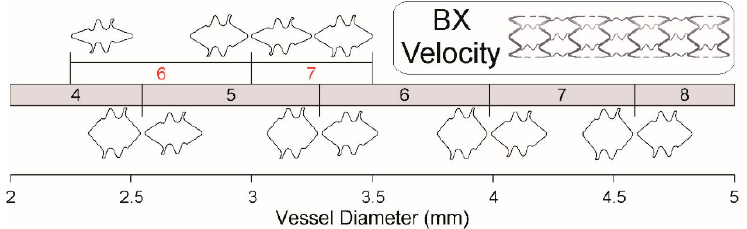
Figure 3. Comparing diameter ranges of a commercial stent vs. its diameter ranges for optimal WSS. The number of repeating units from the manufacturer’s sizing matrix is shown ( red values ) with that from optimization using a TAWSS cost function ( black values ). The geometry of one unit for the limits of each range is also shown. Adapted from Gundert et al.